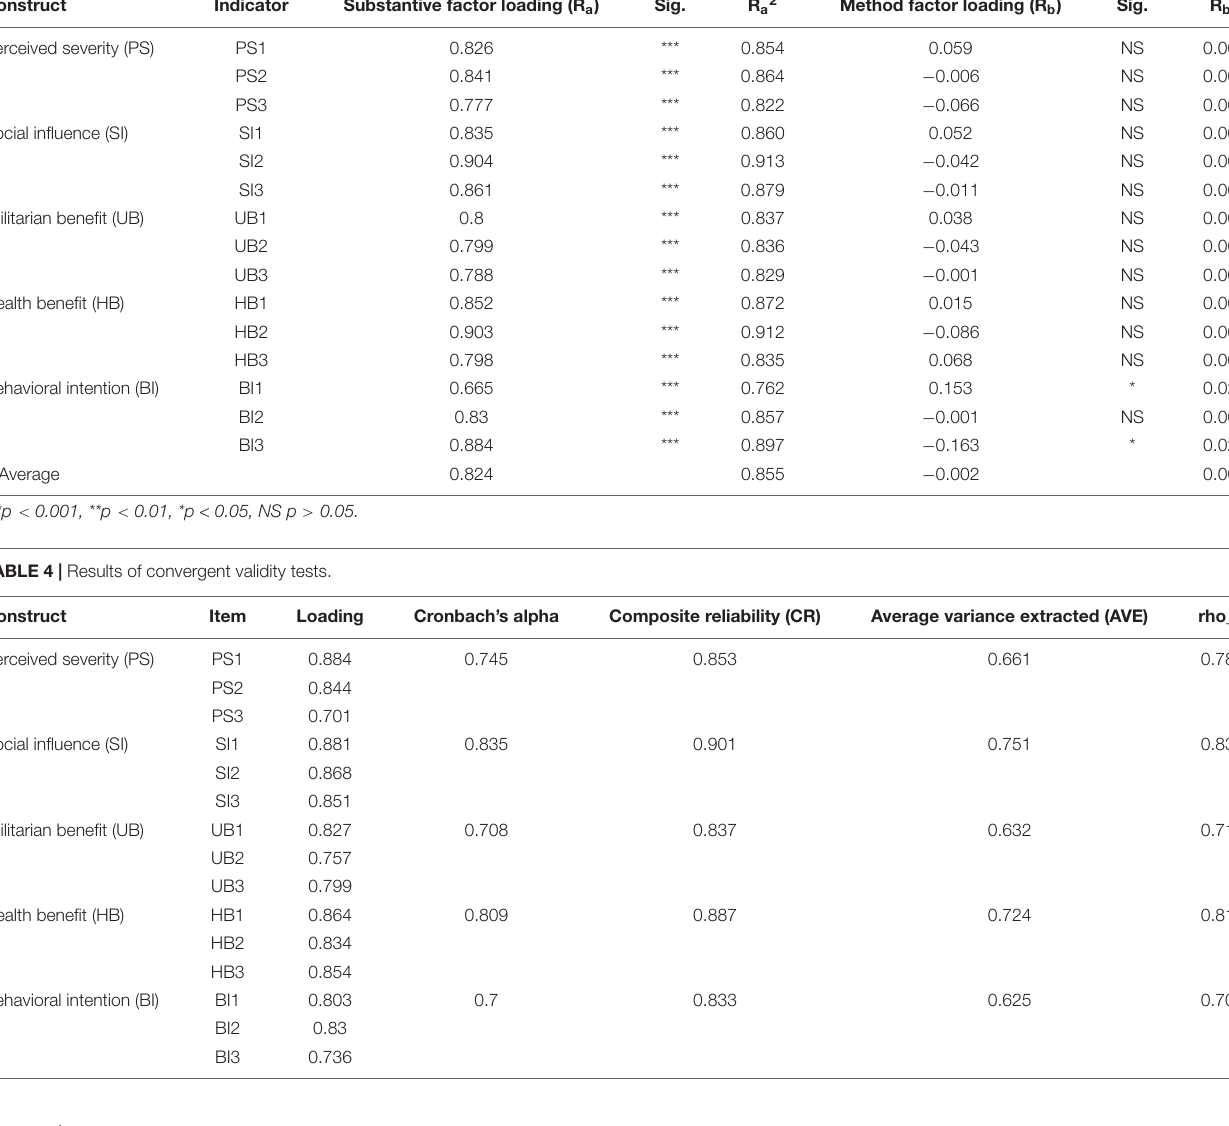
TABLE 5 | Discriminant validity (Fornell and Larcker